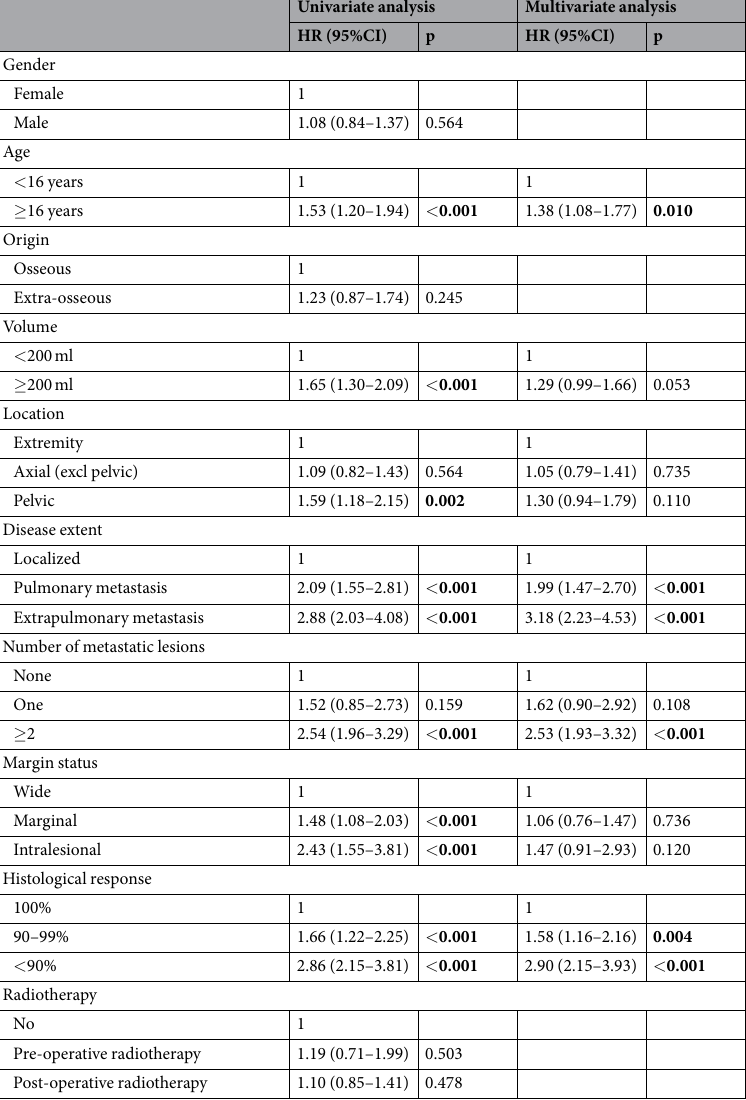
Table 5. Hazard ratio (HR) with corresponding 95% confidence interval (CI) from univariate and multivariate analysis at time of surgery (n = 792).